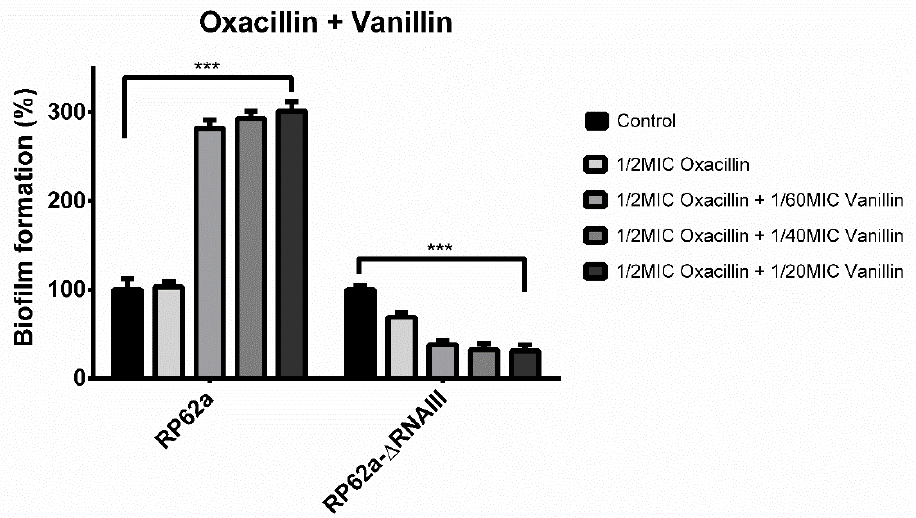
Figure 5. Effect of vanillin in different sub-inhibitory concentrations in combination with 1/2MIC oxacillin on the biofilm formation of S. epidermidis RP62a and RP62a- ∆ RNAIII. As the results show, oxacillin on the biofilm formation of S. epidermidis RP62a and RP62a- Δ RNAIII. As the results show, wild-type biofilm formation was induced up to threefold compared to RP62a- ∆ RNAIII where biofilm wild-type biofilm formation was induced up to threefold compared to RP62a- Δ RNAIII where bio- was inhibited (*** p < film was inhibited (*** p < 0.001).